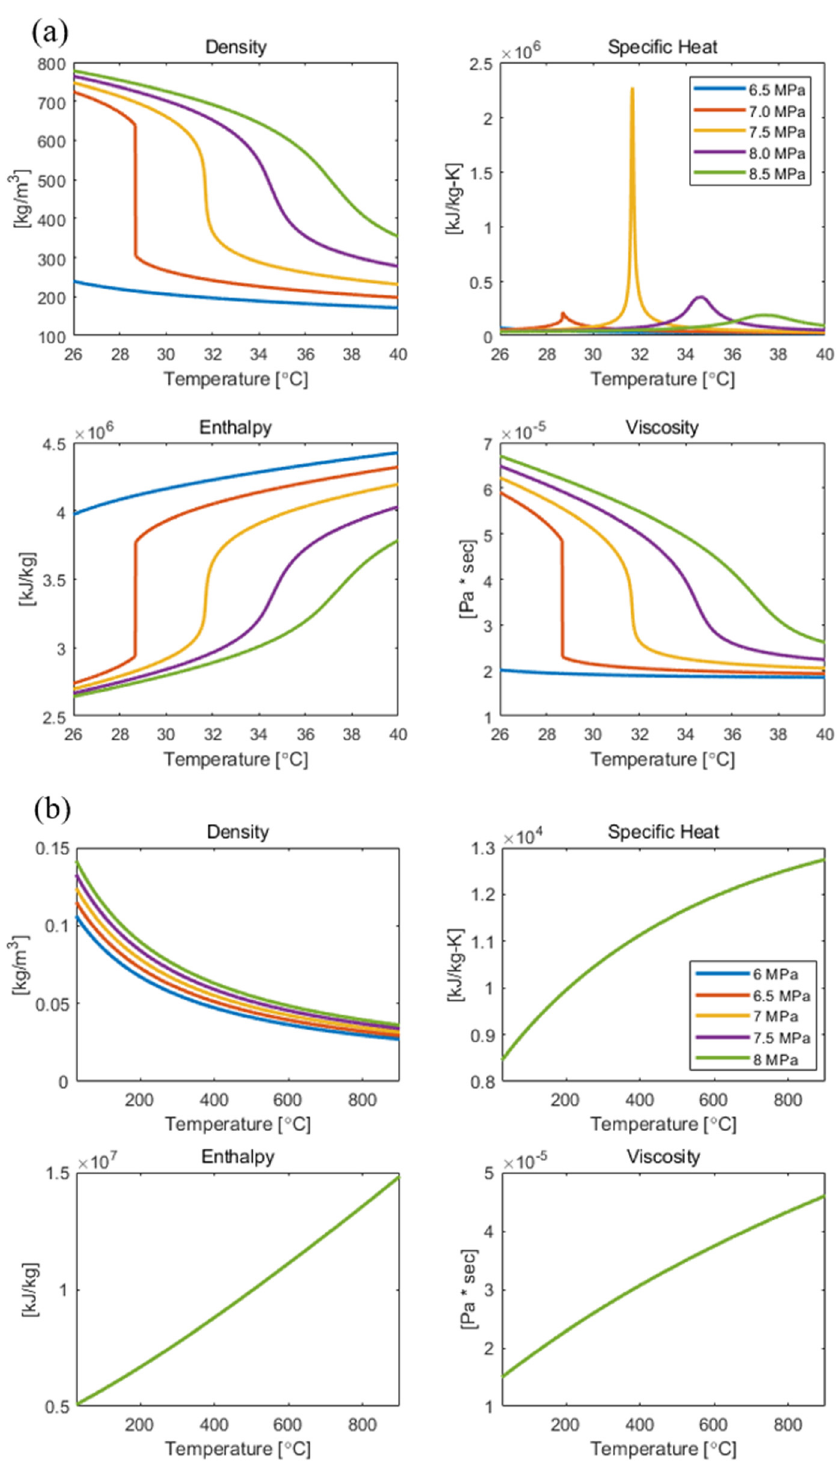
Figure 6. CO 2 Thermal Properties: ( a ) near critical point and ( b ) near turbine operating condition.